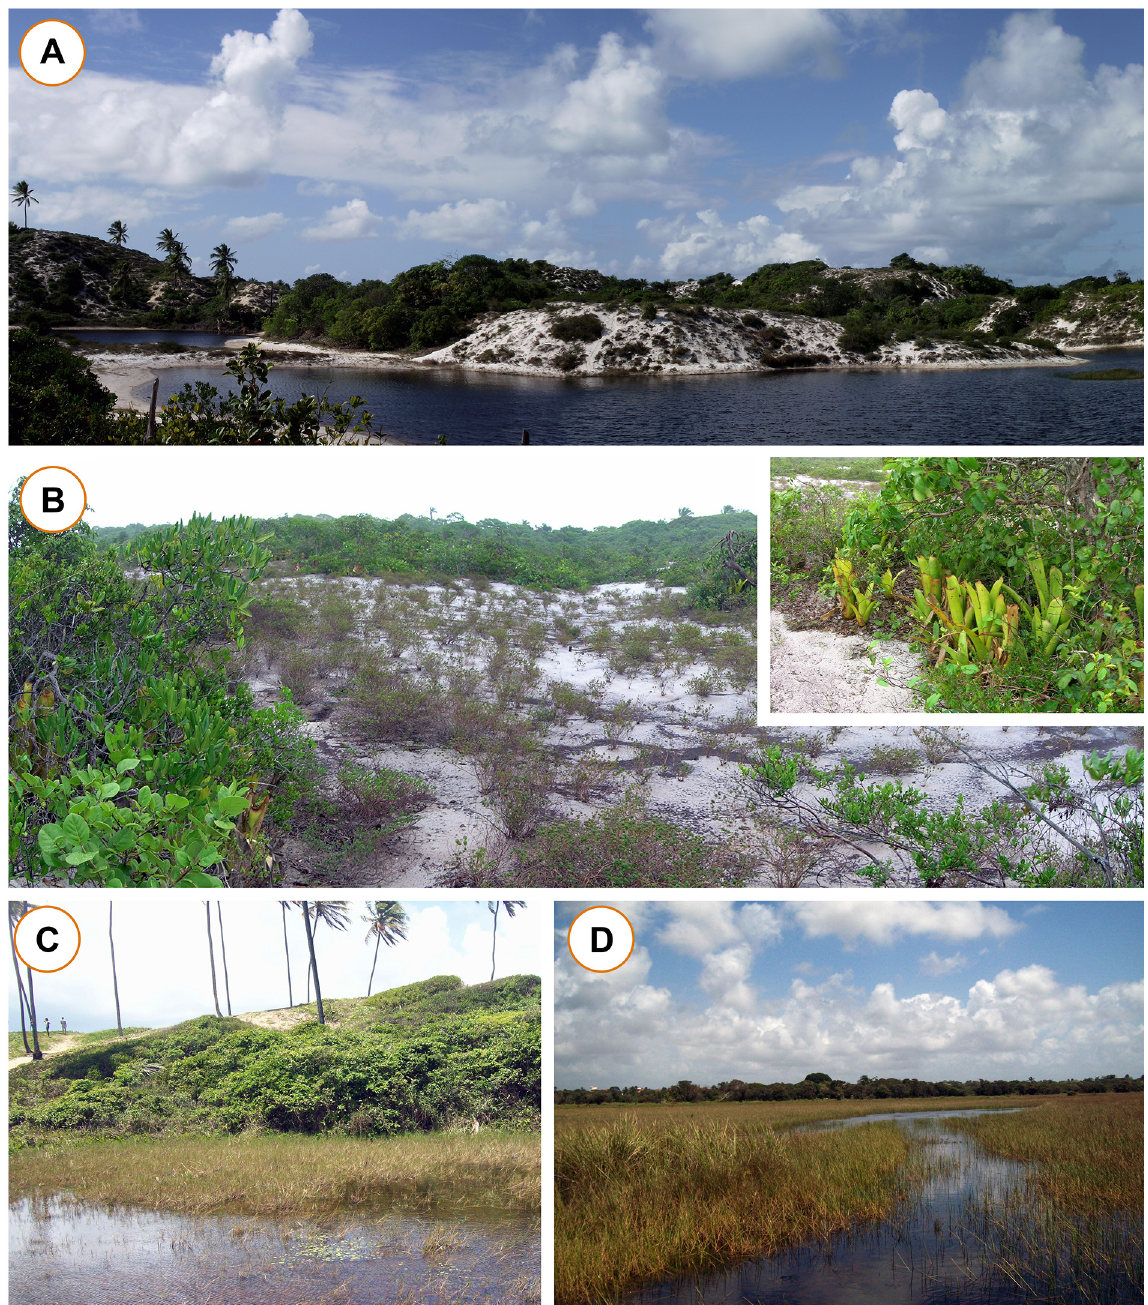
Fig 1. Phytophysiognomies of the Restinga. (A) Panoramic view of the Restinga from Costa Azul, Municipality of Jandaíra, northernmost coast of the Bahia State, northeastern Brazil, featuring freshwater ponds amid sand dunes. (B) A typical Restinga landscape (Praia do Forte, Municipality of Mata de S ã o Jo ã o, Bahia State) characterized by sandy soil covered by many shrubs and terrestrial bromeliads. In several places of the Restinga habitat, terrestrial bromeliads (in detail in the top right corner) are the unique source of water and shelter for anuran species. (C) Temporary pond near a sand dune and (D) floodplain in the Restinga of Arembepe, Municipality of Camaçari, Bahia State. These floodplains are contiguous with sandplains and many amphibian species inhabiting the Restingas commonly use these areas for reproduction and foraging. Photo A, Ariane L. Xavier, 10 June 2012; B, Rafael O. Abreu, 17 June 2006; C and D, Iris Shalon F. Carneiro, 28 September 2014.